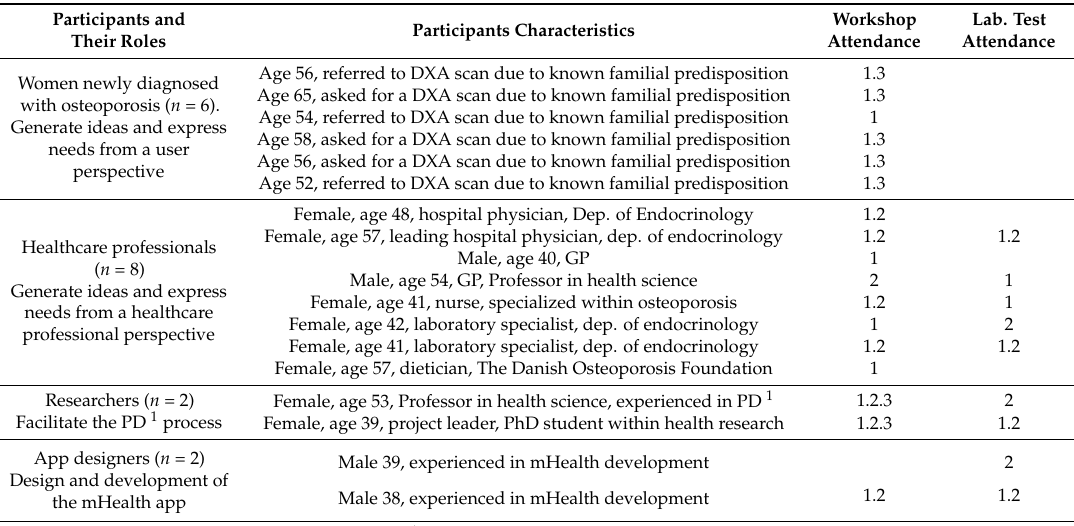
Table 1. Participants in the participatory design team, their characteristics, and contributions in the workshops and laboratory